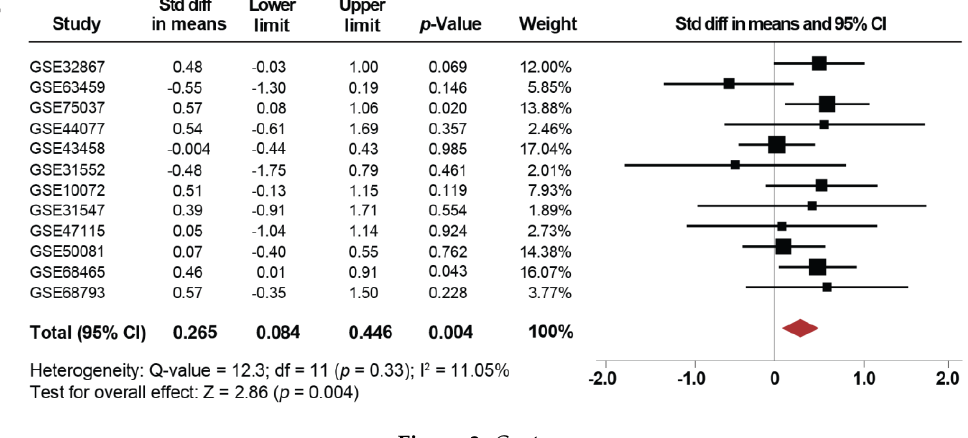
Figure 3. Upregulation of SETDB1 mRNA is correlated with smoking history. ( A ) Forest plot of overall analysis of SETDB1 mRNA expressions between NSCLC patients reported as current smokers compared to non-smoker patients. ( B ) Forest plot of overall analysis of SETDB1 mRNA expressions between NSCLC patients reported as former smokers compared to non-smoker patients. Standardized mean differences (SMD) for each dataset are represented by the squares, and the horizontal line crossing the square represents the 95% CI. The diamonds represent the estimated overall effect. 2.3. Association Between SETDB1 Levels and Pathological Characteristics of the NSCLC Samples Overall, 34 microarray datasets containing information about pathological characteristics were analyzed (Table 1 and Table S1). There was no statistical evidence that pathological stages or tumor- node-metastasis (TNM) stages in ADC and SCC have an association with the expression levels of SETDB1 (Table 2). However, as shown in Supplementary Figure 3B, a possible trend toward significance showing an association between SETDB1 expression and NSCLC patients carrying mutations for the TP53 gene was observed (SMD: 0.15; 95% CI: − 0.004 – 0.31; p = 0.052), with low heterogeneity ( I 2 = 0%; p = 0.60). There was no evidence of publication bias based on the funnel plot and Egger’s test ( Figure S2G). No associations were found between SETDB1 expression and NSCLC patients carrying mutations for neither the Epidermal Growth Factor Receptor ( EGFR ) nor the KRAS oncogenes (Table 2). Collectively, these findings suggest that high levels of SETDB1 mRNA are not dependent on an NSCLC patient’s gender or age and are maintained at every clinical stage during the carcinogenic process. Table 2. Analysis of the association between SETDB1 mRNA expression and clinical and pathological characteristics. Characteristics Std Diff in Means Lower Limit Upper Limit p -Value Clinical Characteristics Size and extent of the main tumor (T)